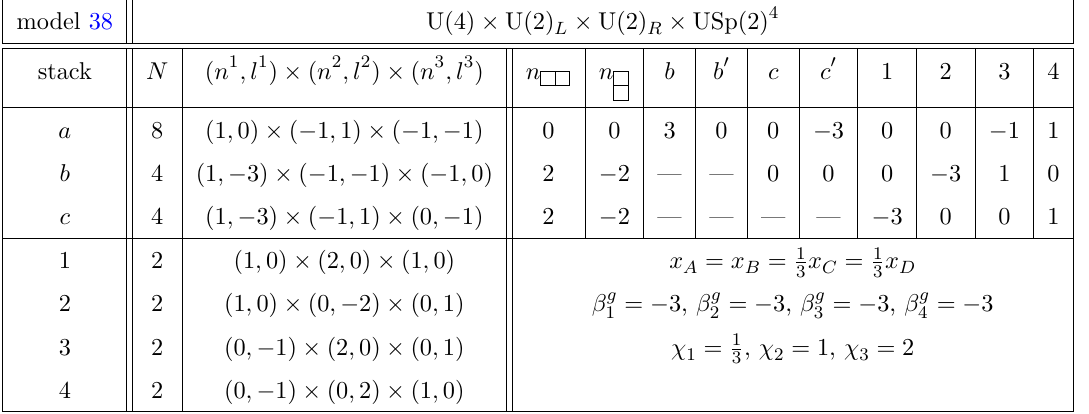
Table 38 . D6-brane configurations and intersection numbers of Model 38, and its MSSM gauge